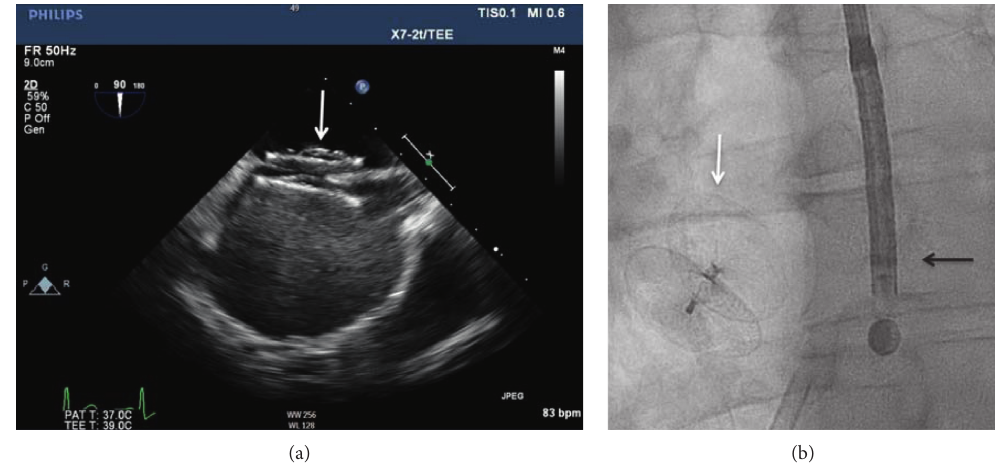
Figure 2: The Occlutech ASD device (white arrow) using the microtransesophageal echocardiography (micro-TEE) probe (a) and fluoroscopy (b). The black arrow indicates the micro-TEE probe during